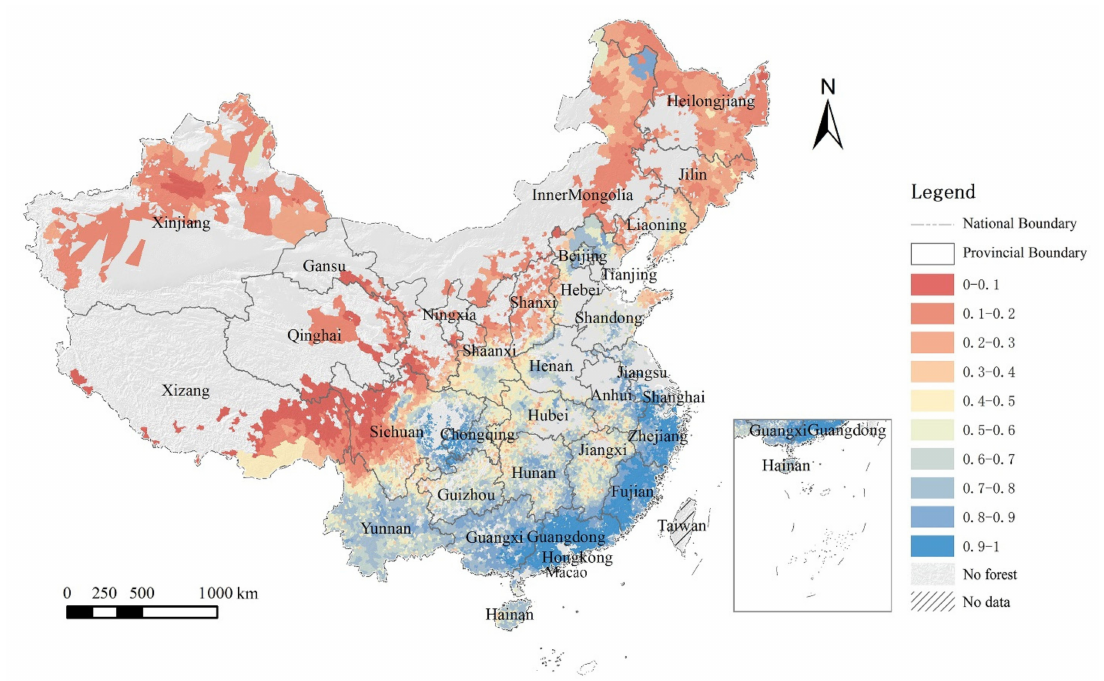
Figure 7. The development suitability (DI) of FHBs in